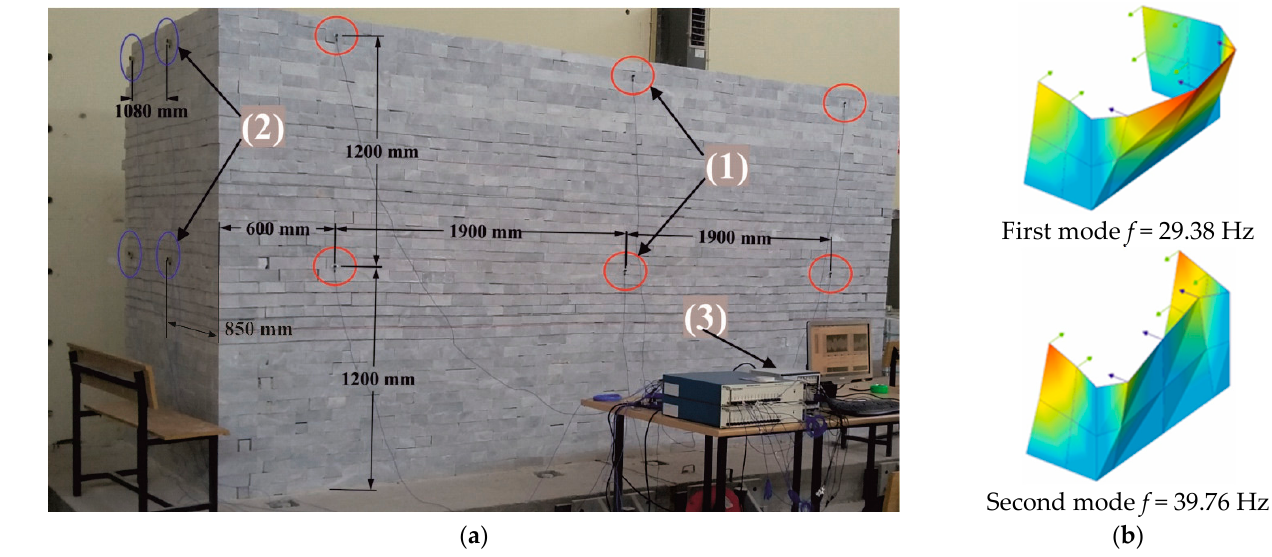
Figure 4. ( a ) AVT setup (1: front wall accelerometers shown inside the red circles, 2: left transversal wall accelerometers shown inside the blue circles, 3: data acquisition system), and ( b ) first two free vibration modes of the DMW specimen.